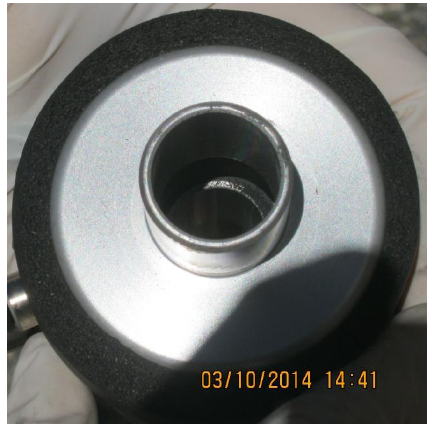
Figure 6. Condensation water trap during a cleaning on 3 October 2014. Black powder was visible in the condensation water trap. The black around the outside of the trap is insulating